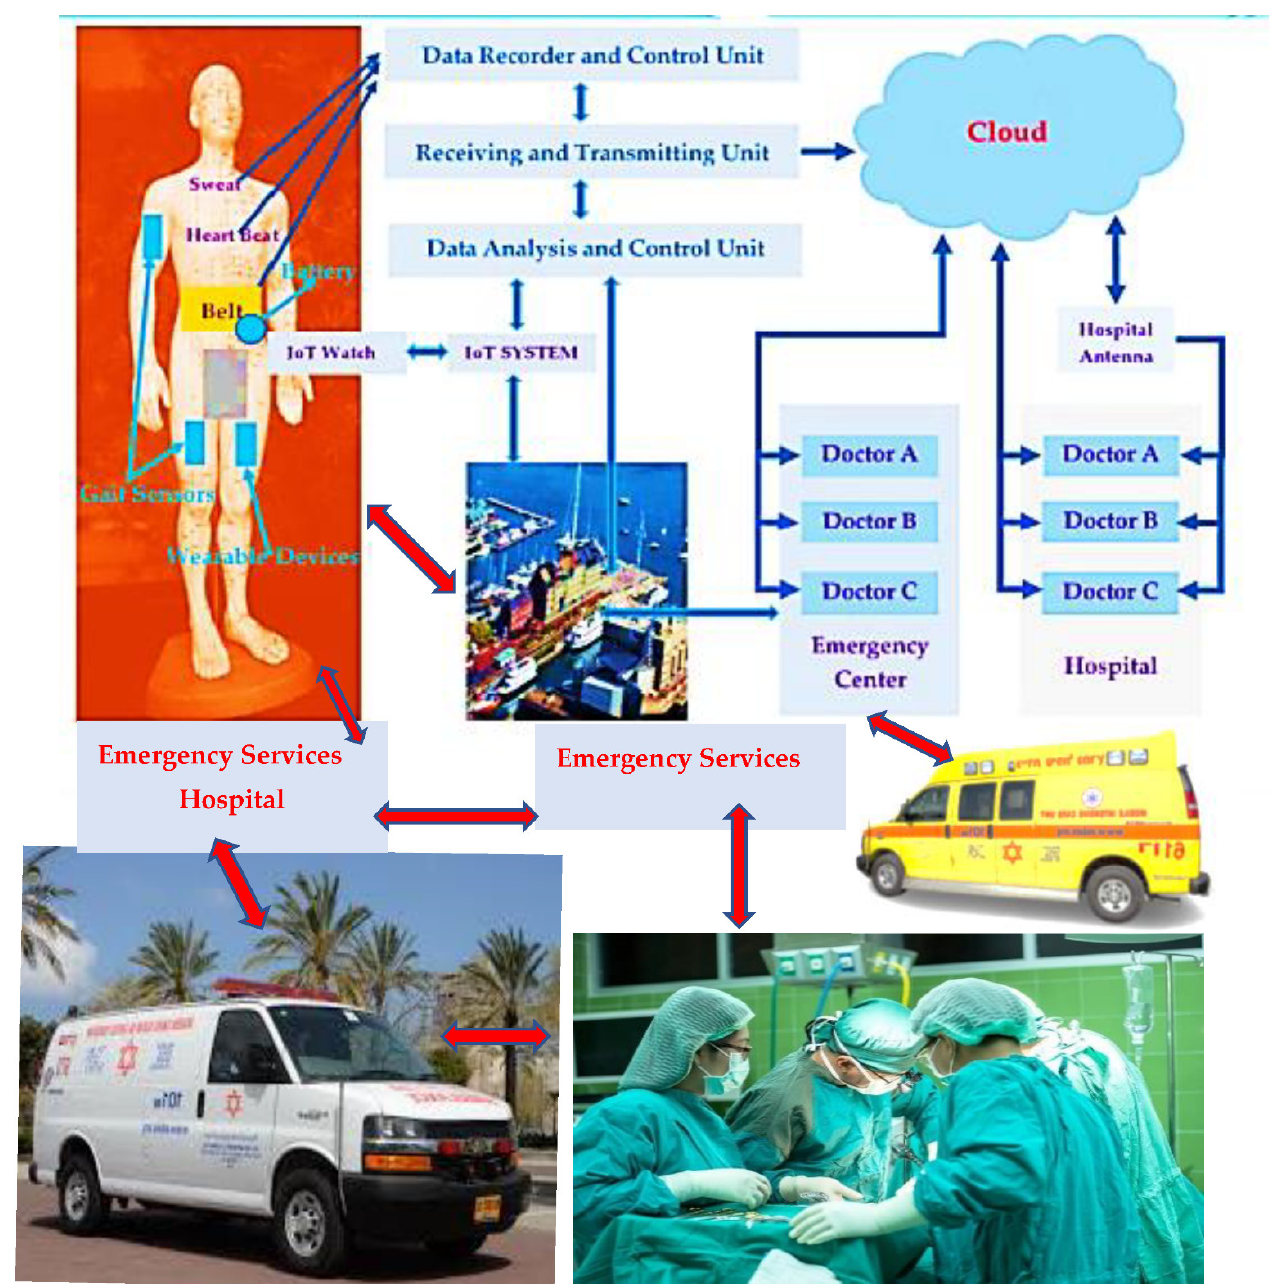
Figure 27. ( a ) Photo of the lab module of the Active Circular Stacked antenna ( b ) A photo of the lab module of the Active Circular Polarized patch ( c ) Layout of the Active Antenna modules analysis.